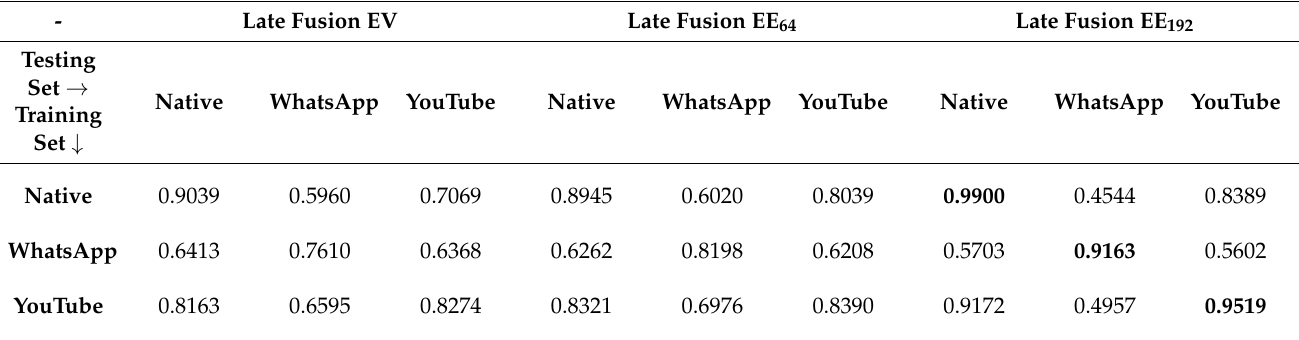
Table 3. Classification accuracy of Late Fusion as a function of training/testing sets. In bold, the highest achieved accuracy in non-cross test